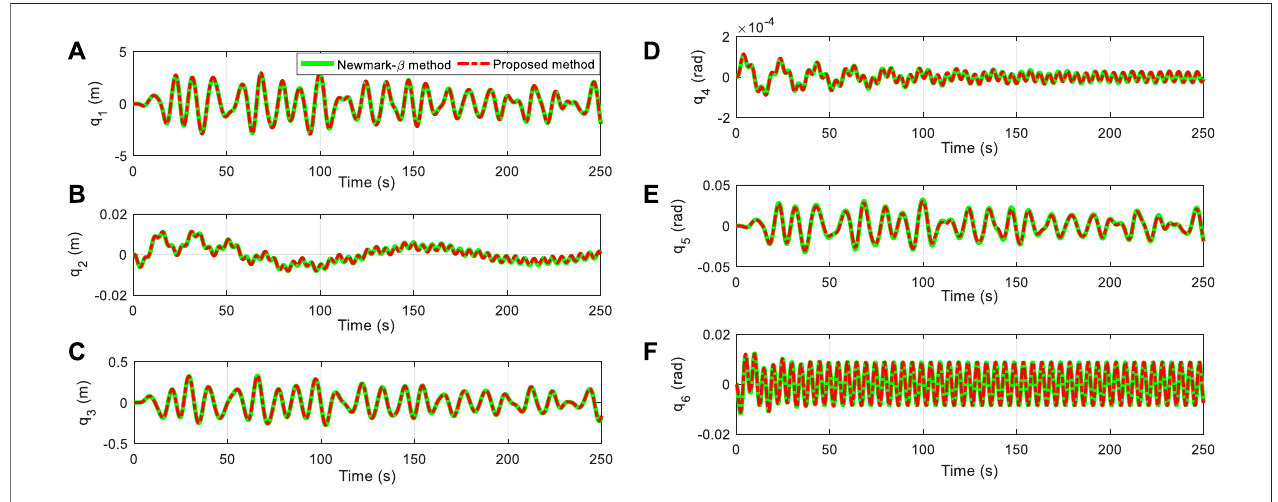
FIGURE 10 | Dynamic response comparison of the Newmark- β and proposed methods. (A) q1(t); (B) q2(t); (C) q3(t); (D) q4(t); (E) q5(t) and (F) q6(t).